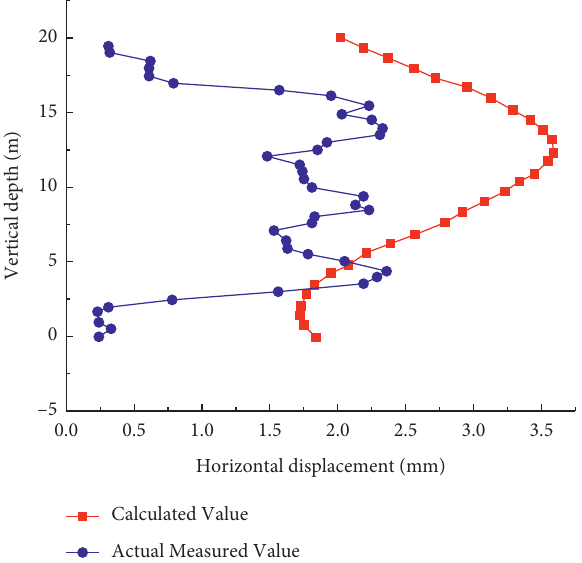
Figure 11: Comparison of calculated value and monitoring data of horizontal displacement. y along the X